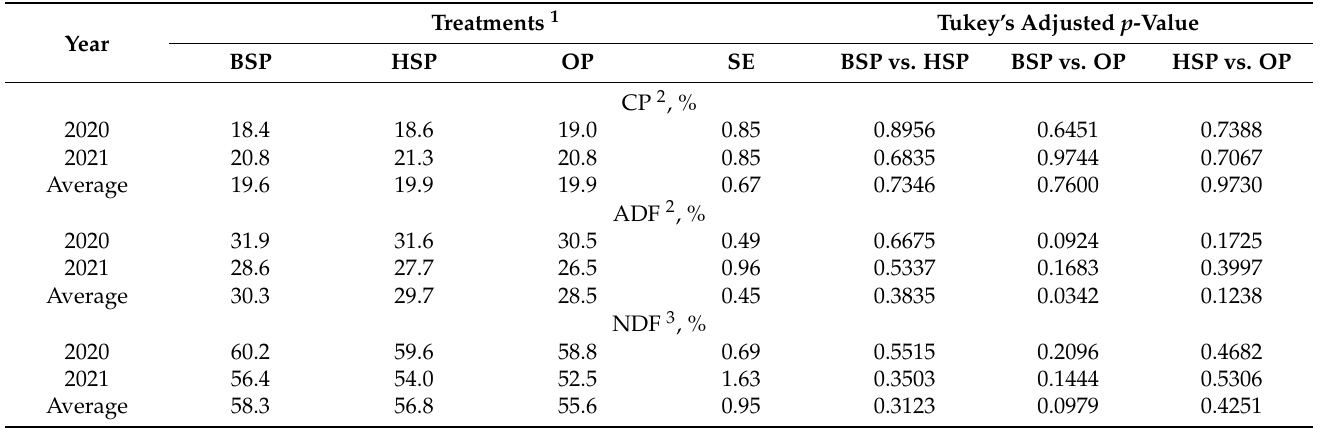
Table 4. Forage nutritive value in an open pasture (OP), black walnut silvopasture (BSP), and honeylocust silvopasture (HSP) treatments during the summers of 2020 and 2021 at the Whitethorne Agroforestry Demonstration Center, Blacksburg, VA,